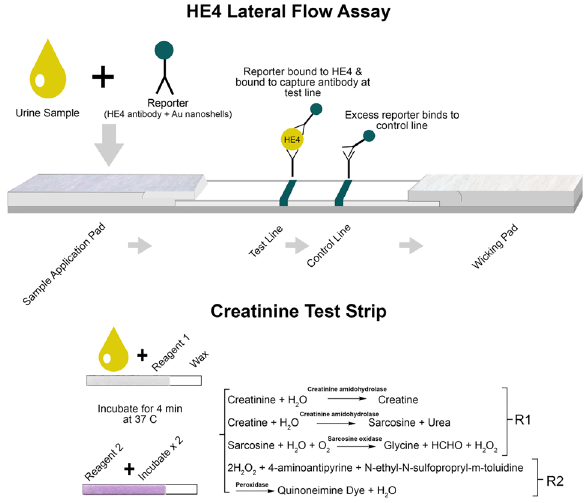
Figure 4. Schematic of the two paper test strips and components. For the HE4 test strip (top), the sandwich assay captures the biomarker in the middle at the test line. The control line is generated when excess reporter binds. For the creatinine test strip, a two reagent system is used to generate a colorimetric reaction with creatinine from light to dark purple. The intensity of the purple color (bottom) indicates the amount of creatinine . The two strips are placed in a scanner or cassette for the cell phone to